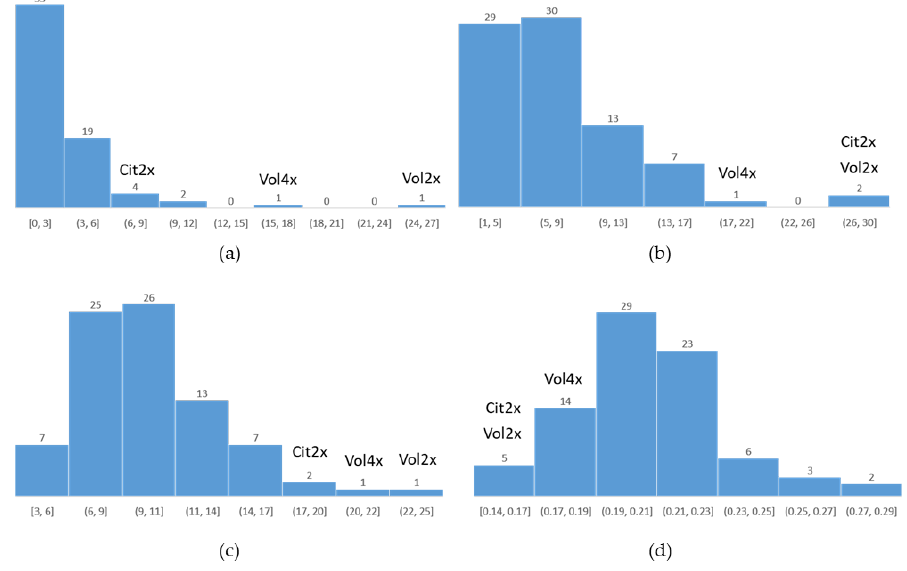
Figure 5. Distribution of the four root phenotypic traits in the 4 × Volkamer lemon × 4 × Swingle citrumelo progenies. ( a ) Number of secondary roots; ( b ) root surface; ( c ) root length; ( d ) root diam- eter.